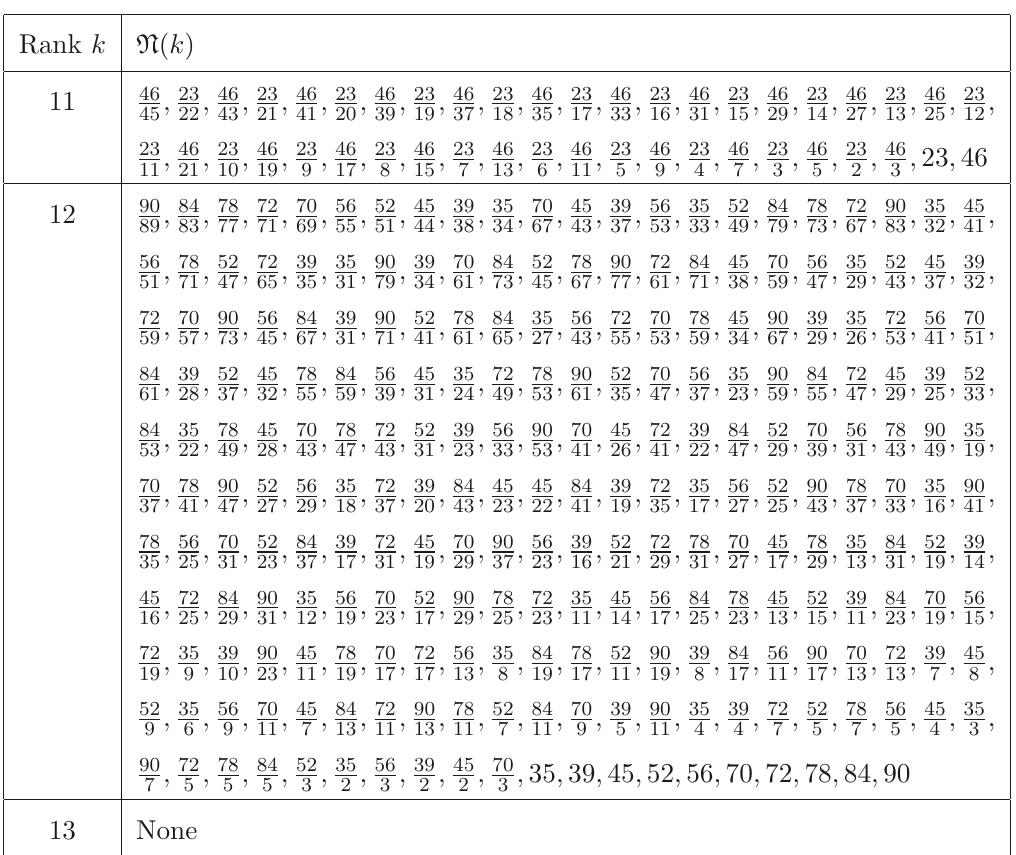
Table 8 . New-dimension sets for ranks 1